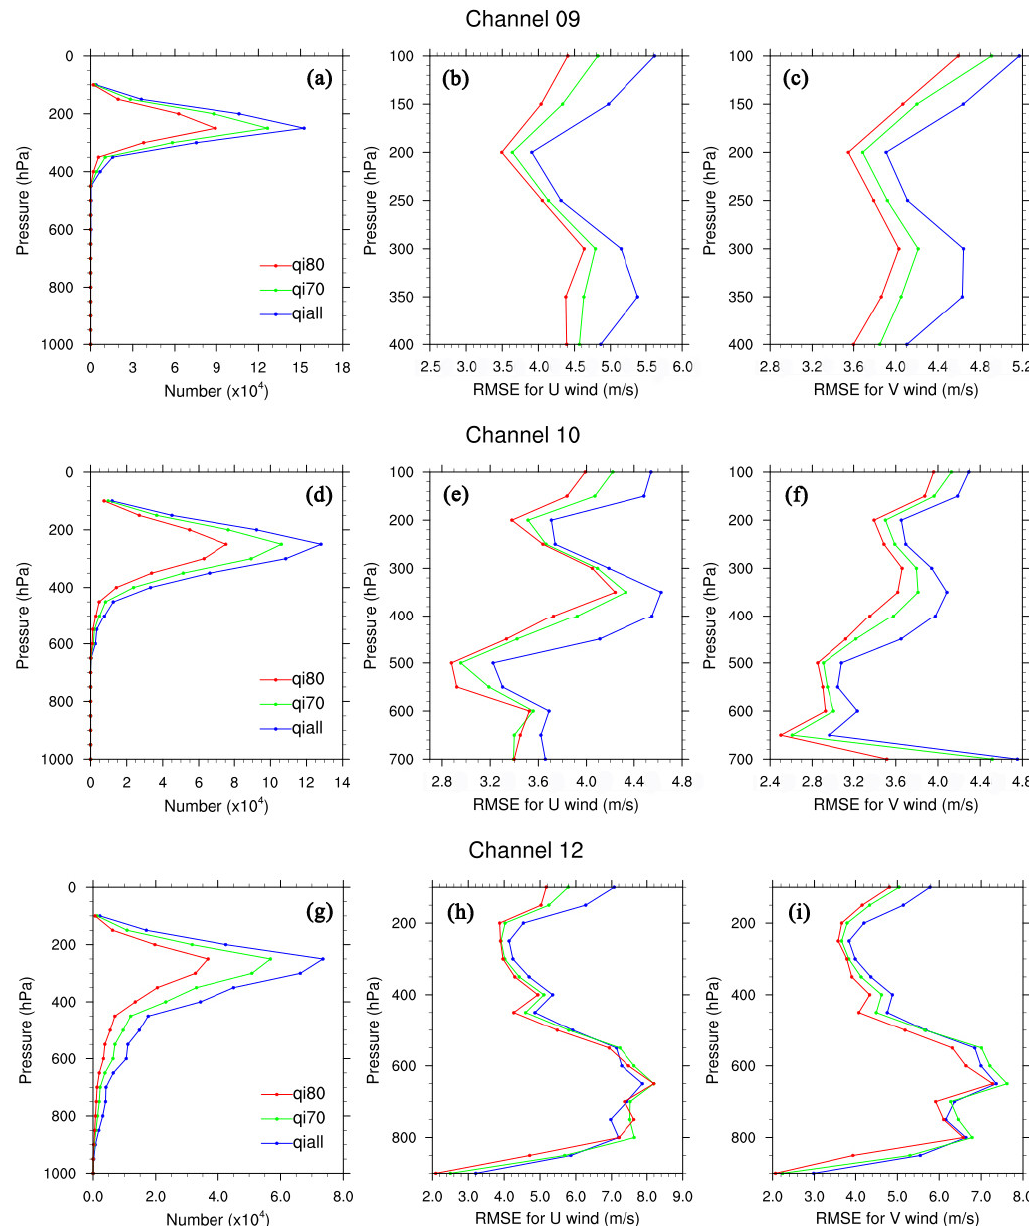
Figure 3. Statistical characteristics of FY-4A AMVs with different QI values (qi80: QI > 80; qi70: QI > 70; qiall: QI > 0) based on the NCEP re-analysis data over one month from 1 to 31 July 2021. ( a , d , g ) represent the number of AMV data for channel 9, 10 and 12, respectively; ( b , e , h ) represent the corresponding RMSEs of U wind; ( c , f , i ) represent the corresponding RMSEs of V wind.